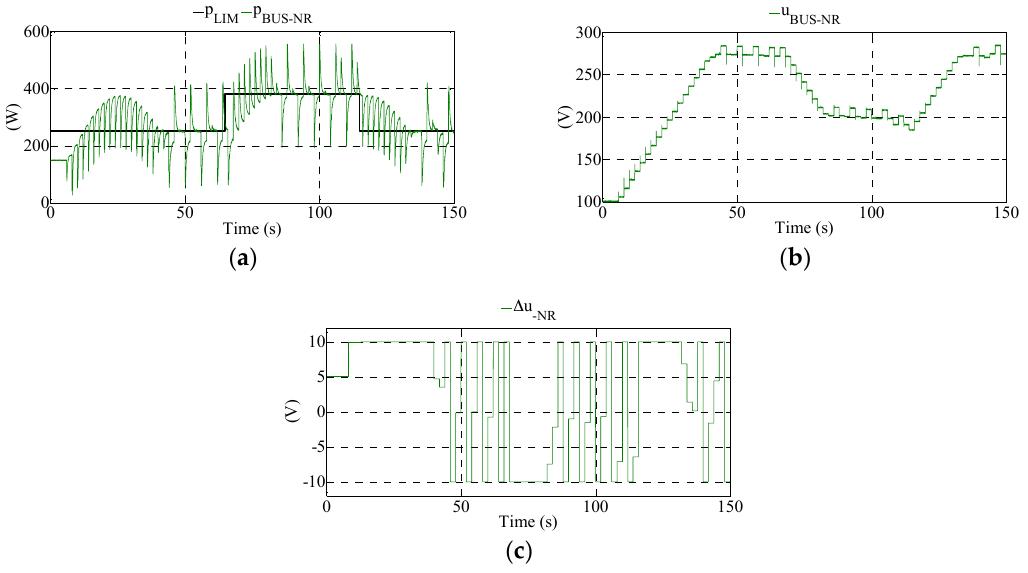
p ; ( b ) Evaluations of u ; ( c ) BUS BUS